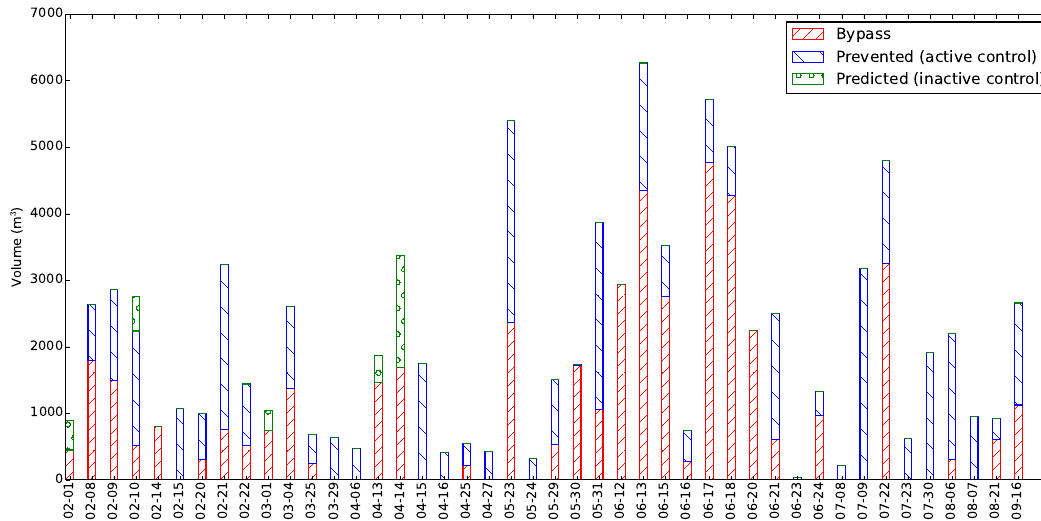
Figure 2. Performance of the predictive control at WWTP Bennekom for the period February–September 2016.